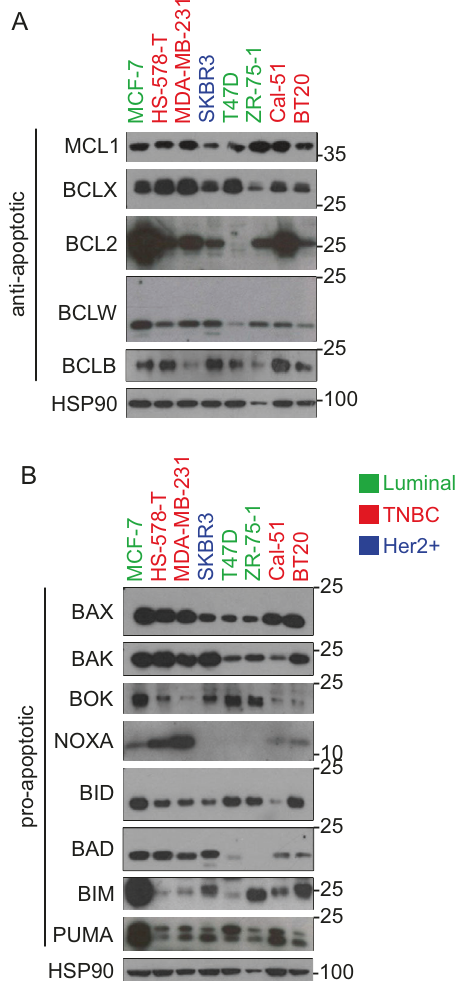
Fig. 3 BCL2 protein family expression in different BC cell lines. Different BC cell lines were subjected to western blotting using the indicated antibodies recognising A anti- and B pro-apoptotic BCL-2 proteins. HSP90 was used as a loading